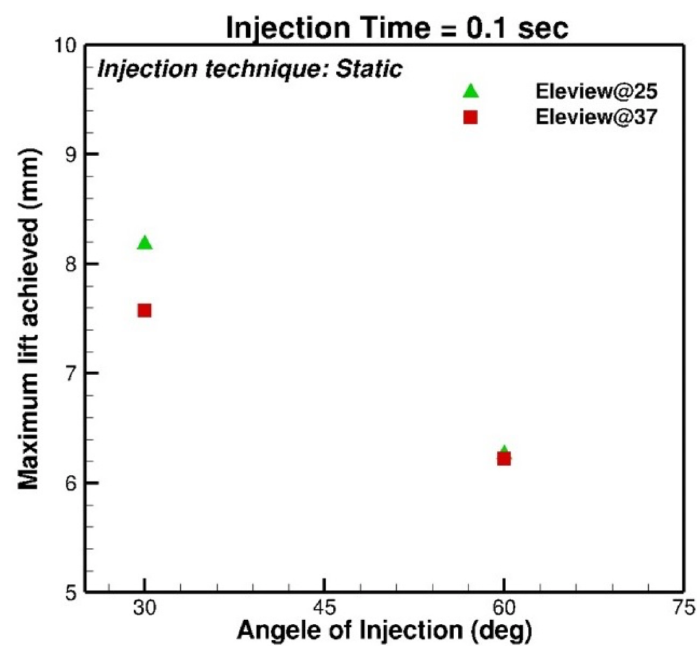
Figure 5. Comparison of Eleview R (cid:13) gel at 25 ◦ C and 37 ◦